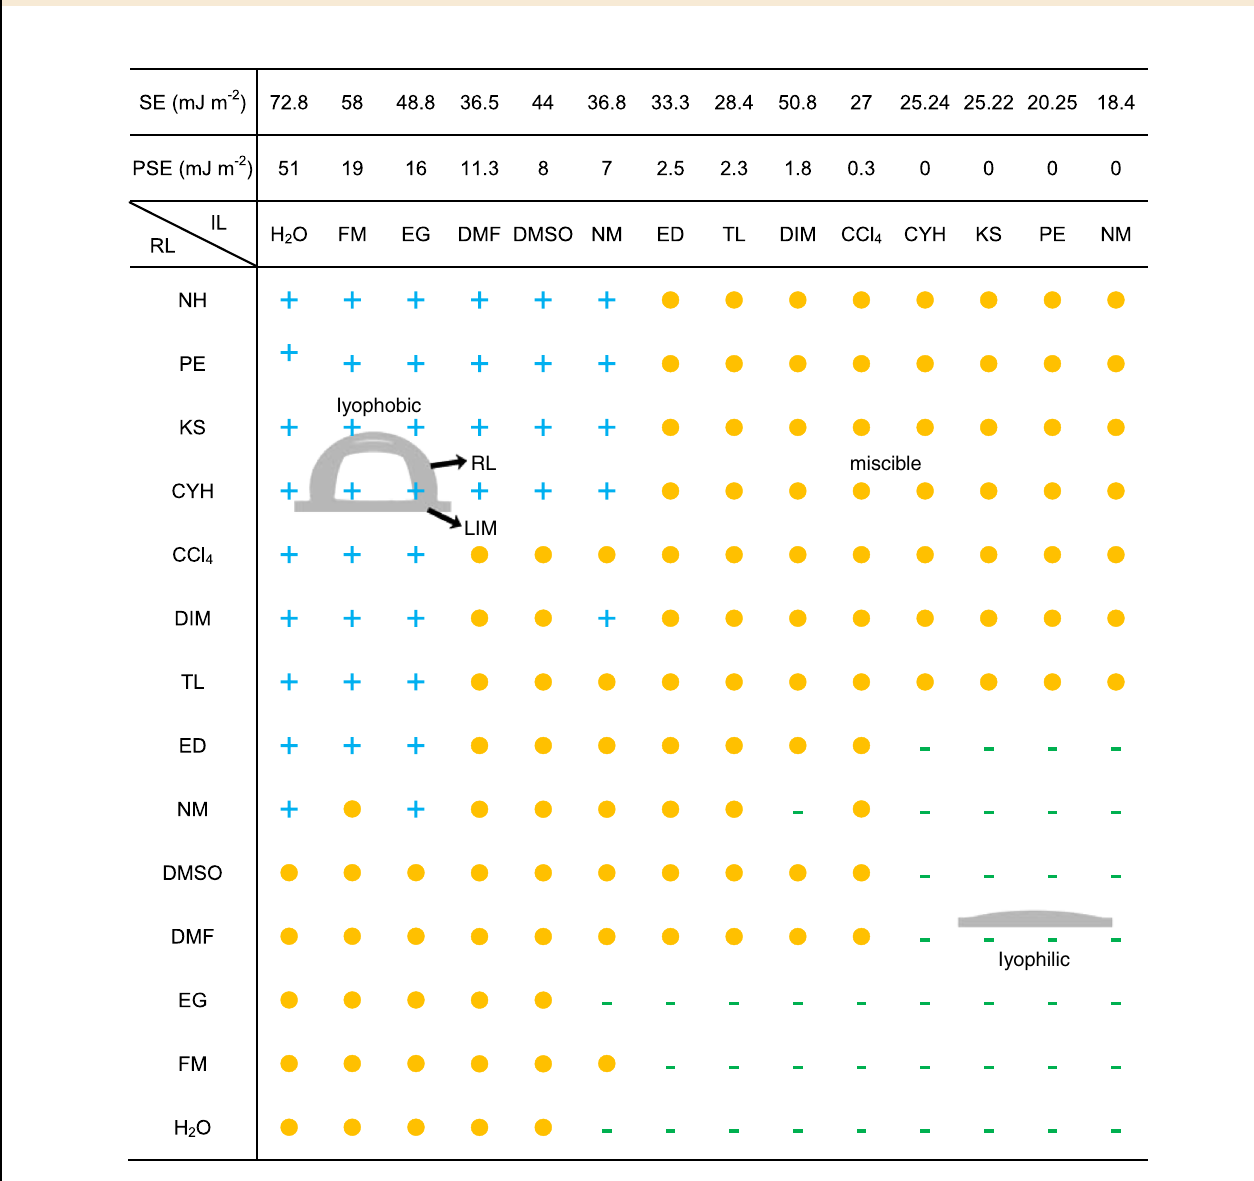
Table 1 Infused-liquid-switchable wetting behavior of STPNMs for a series of liquid